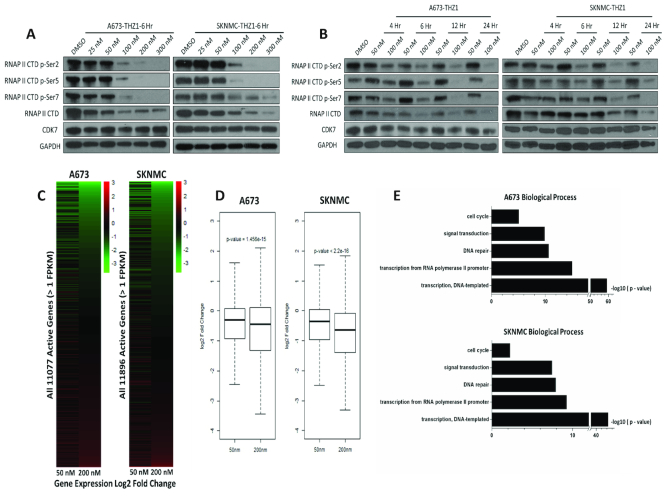
THZ1 selectively inhibits RNAPII-mediated transcription in Ewing sarcoma, (A, B) Immunoblotting analyses of RNAP II CTD phosphorylation in A673 and SKMNC cells treated either with THZ1 or DMSO at the indicated concentrations for the indicated durations. (C) Heatmap and (D) Box plots showing changes in gene expression in A673 and SKNMC cells following treatment with either 50 or 200 nM THZ1 for 6 h. (E) Selected Gene ontology (GO) functional categories of transcripts decreased over 2-fold in A673 and SKNMC cells following 50 nM THZ1 treatment for 6 h.